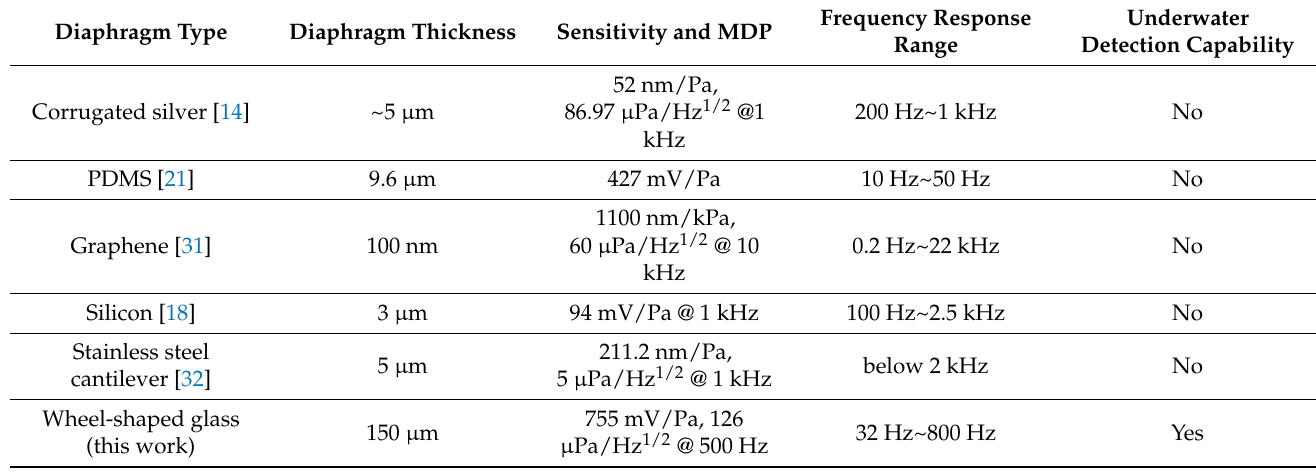
Table 1. Performance characteristics of existing and our fiber-optic